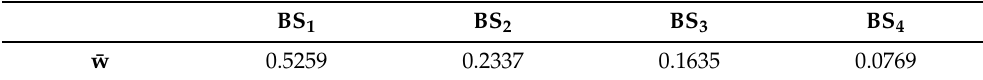
Table 8. The importance weight of business scenarios in